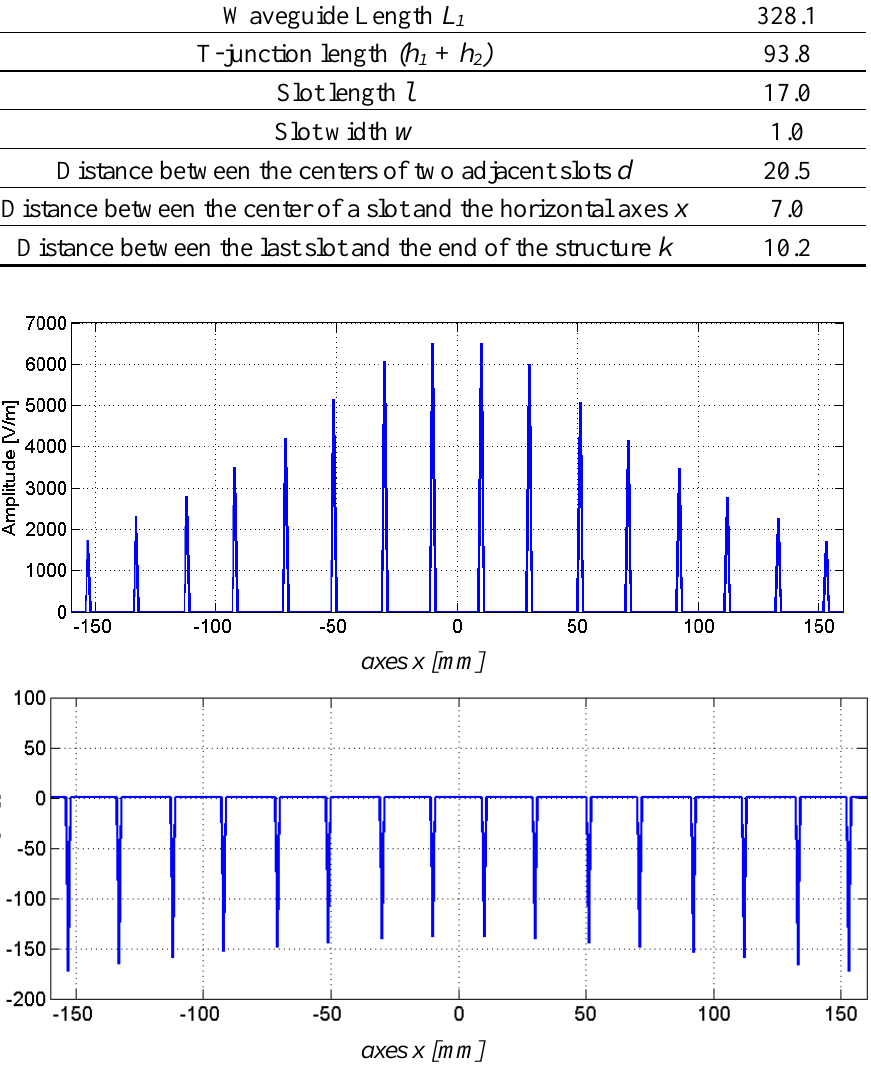
Figure 4. Amplitude ( Top ) and phase ( Bottom ) of the E field radiated by each slots obtained with the optimized